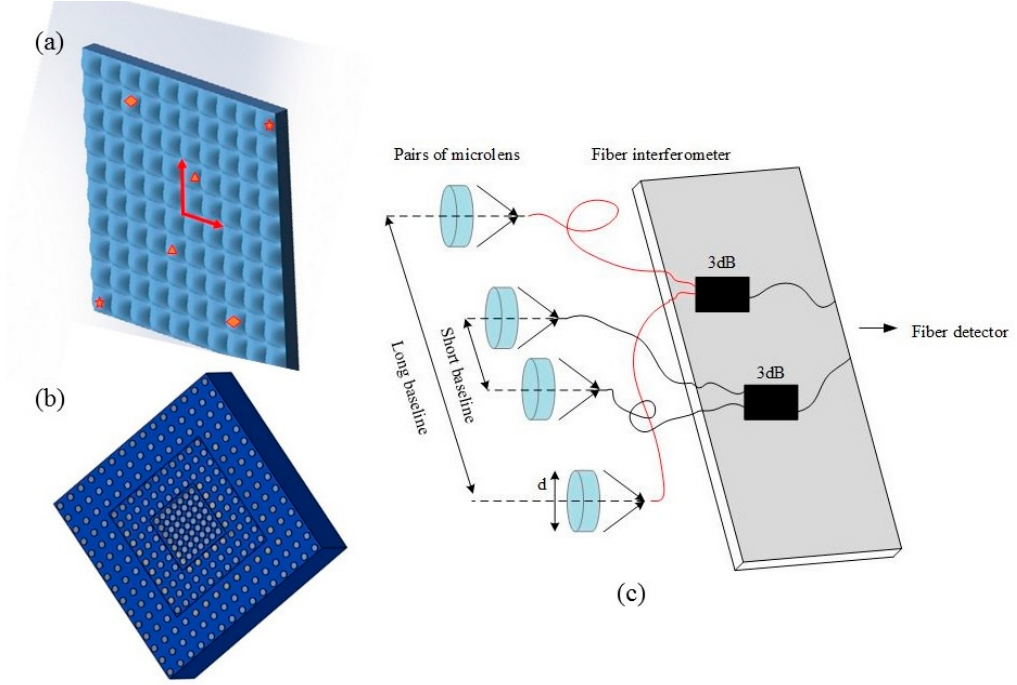
Figure 1. ( a ) Rectangular microlens array using a symmetric pairing method; ( b ) microlens array using a complex rectangular sub-aperture arrangement method; ( c ) structure of the fiber interferometer.